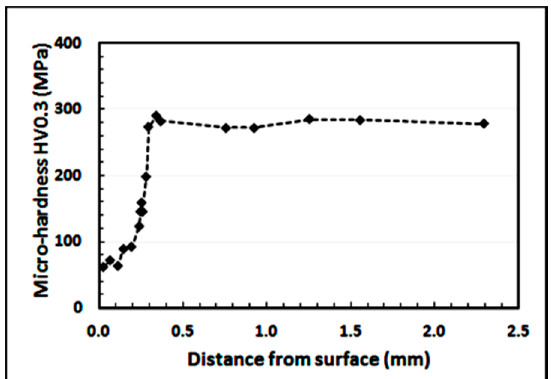
Figure 9. Impact of surface carbon diffusion on the microhardness of sintered Co pellets (set III, 1000 °C).